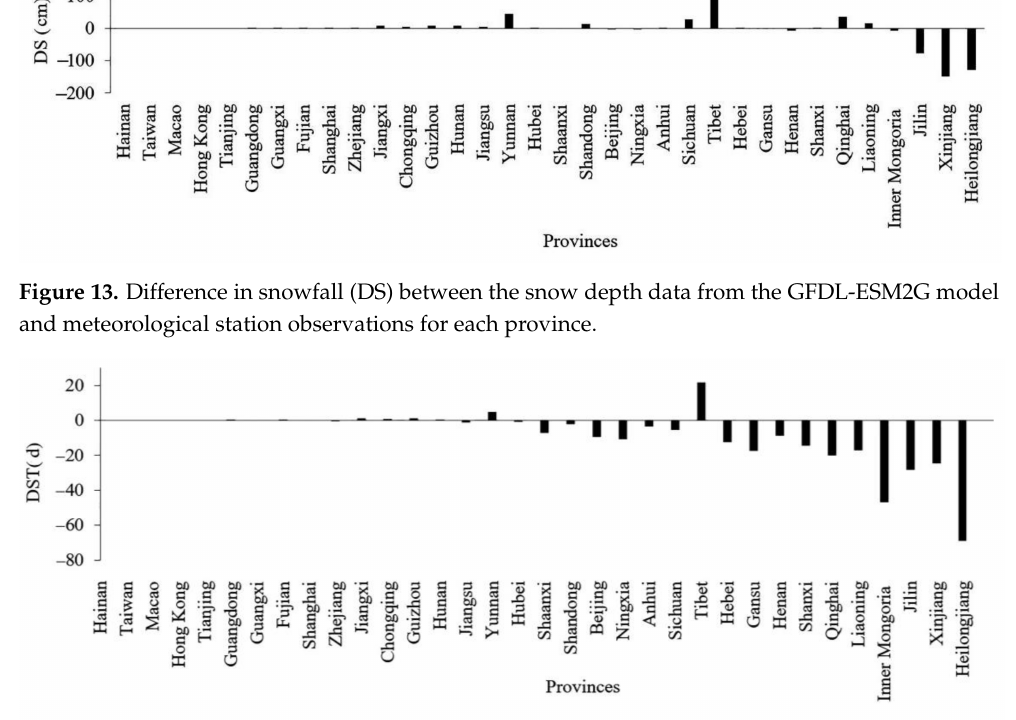
Figure 14. Difference in accumulated snow time (DST) between the GFDL-ESM2G model and meteorological station observations for each